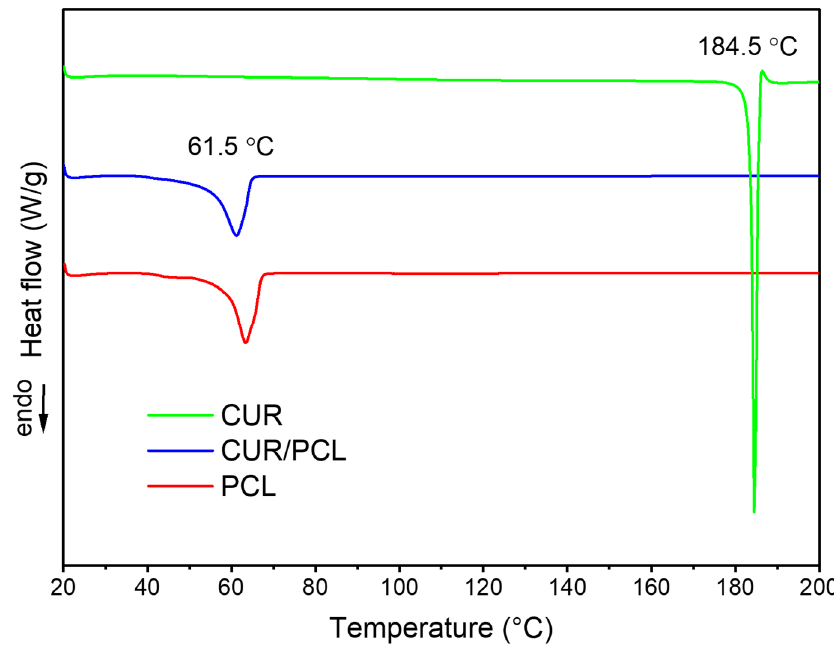
Figure 7. Differential scanning calorimetry (DSC) thermograms of pure curcumin (CUR), blank, and curcumin-loaded PCL scaffolds (7%, w / w ) .